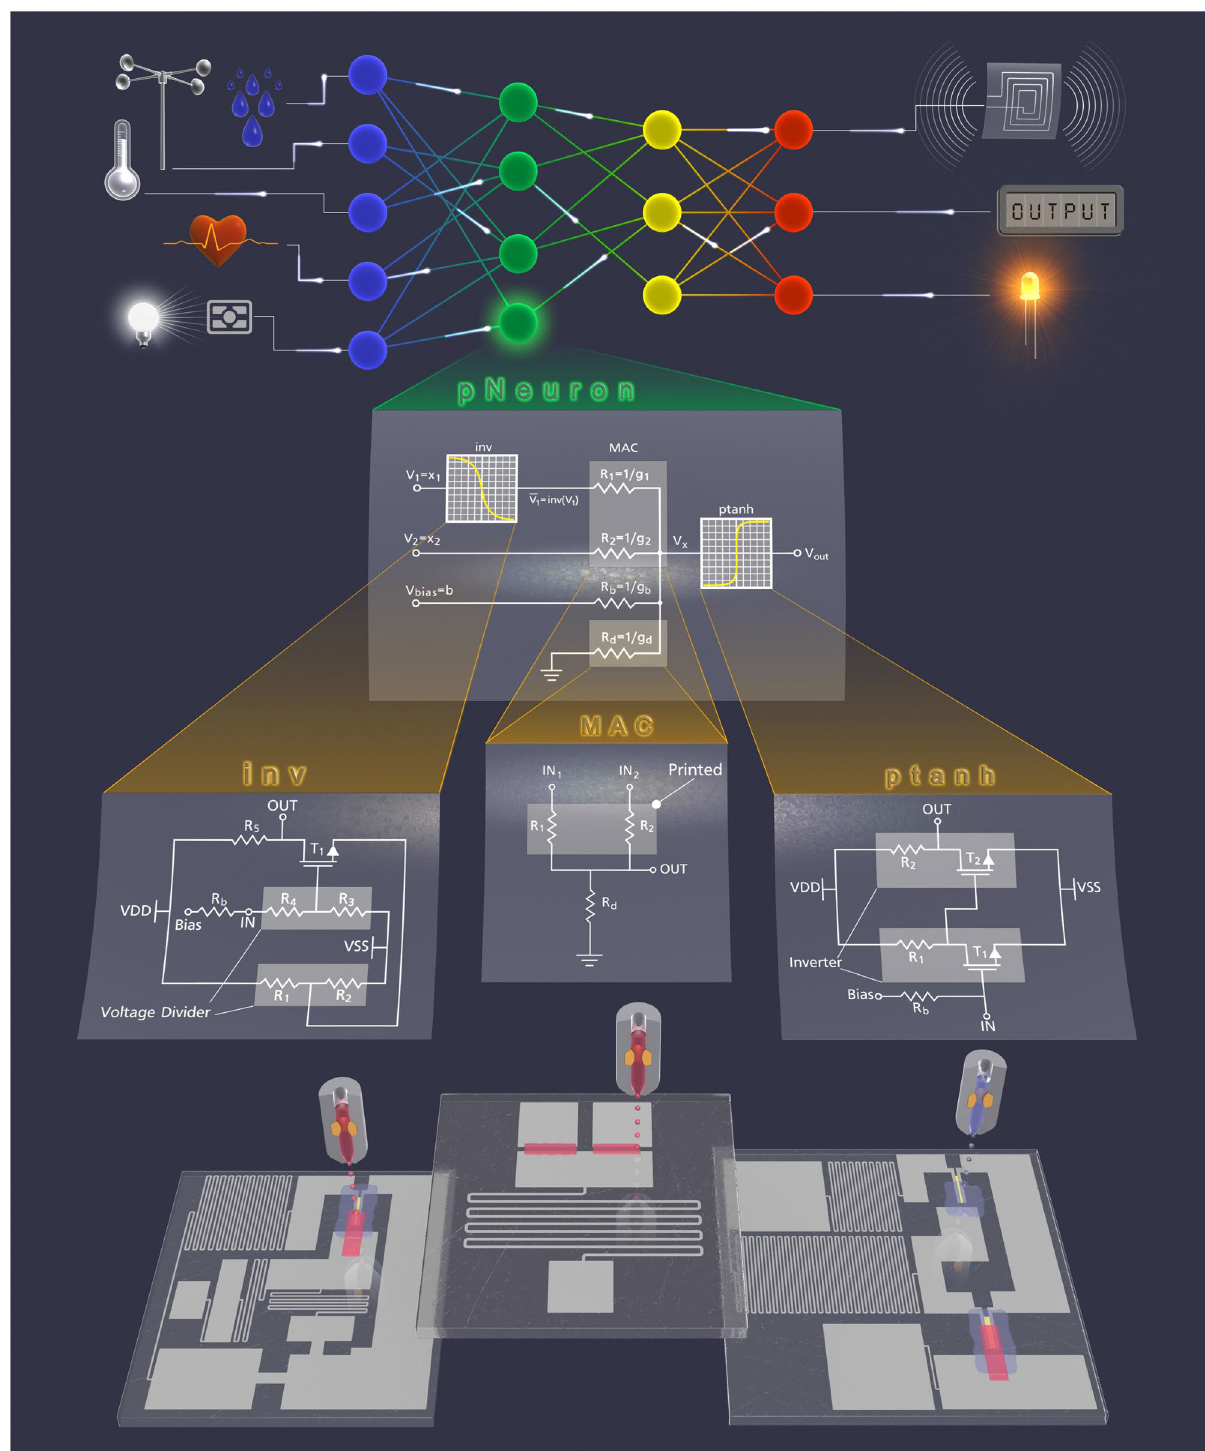
Figure 1. Top: Printed Neural Network with sensor inputs and actuators, Middle: circuit schematics of the inkjet-printed neuron (pNeuron) and the hardware prototypes of its three fundamental building blocks: negative weights circuit (inv), multiply accumulate operation (MAC) and non-linear tanh-like activation function (ptanh) Bottom: physical layout of the hardware